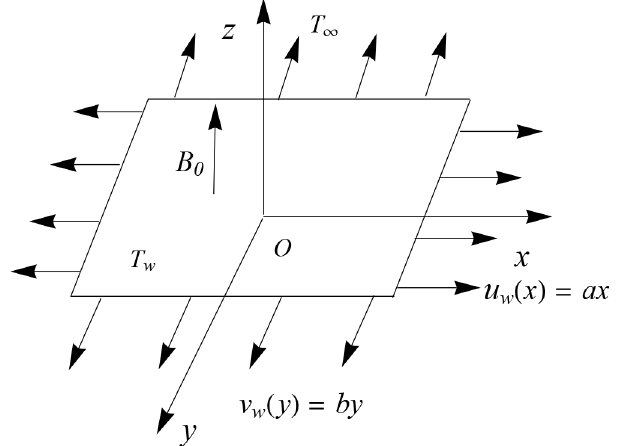
Fig 1. Geometry of the